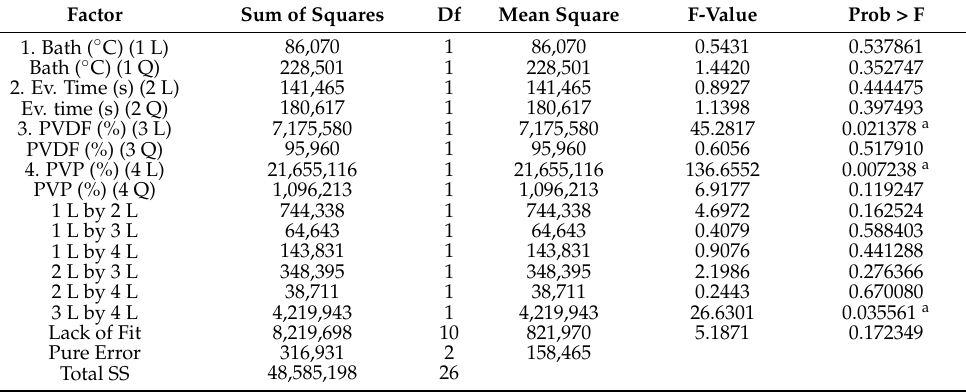
Table 4. Analysis of variance of pure water flux (L m − 2 h − 1 ). R 2 = 0.8243; Pure error = 158,465.3. (L) is the linear relation, (Q) is the quadratic relation of the factors, and Df is the degrees of freedom of the analysis.